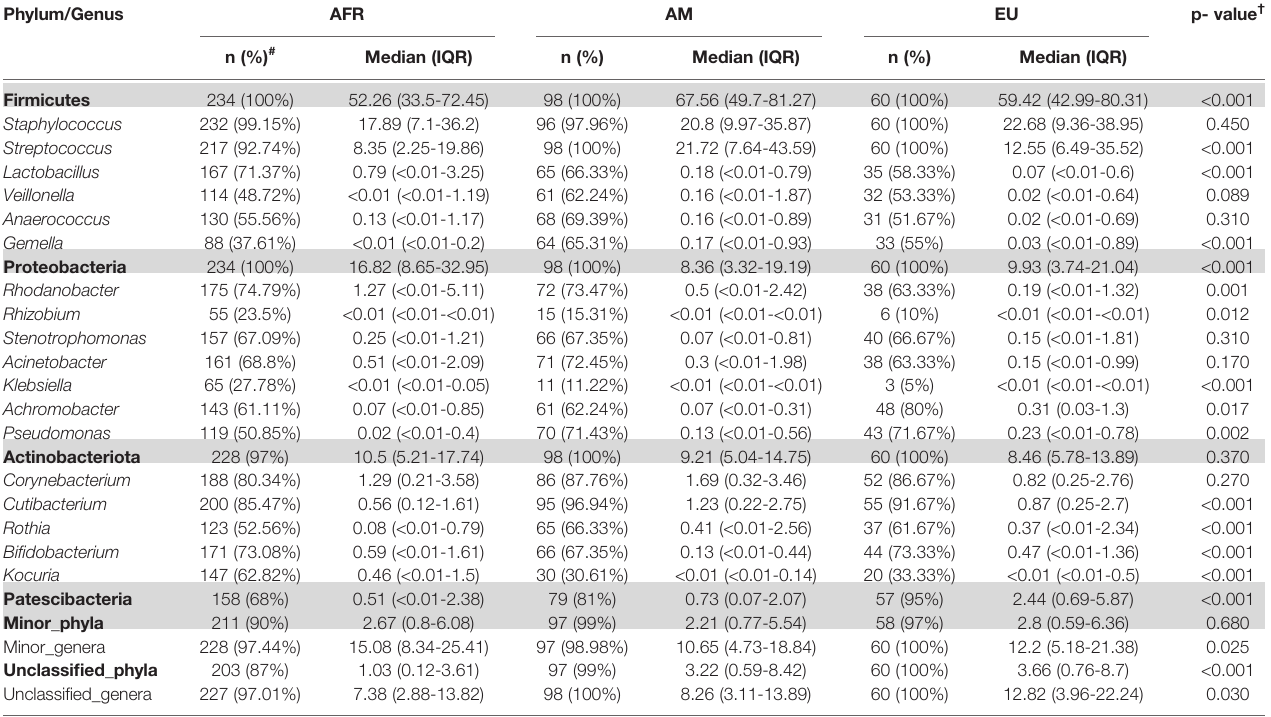
TABLE 2 | Relative frequencies, medians and interquartile range (IQR) of the most abundant bacterial phyla (bold) and genera detected in milk samples from women in different continents. Phylum/Genus